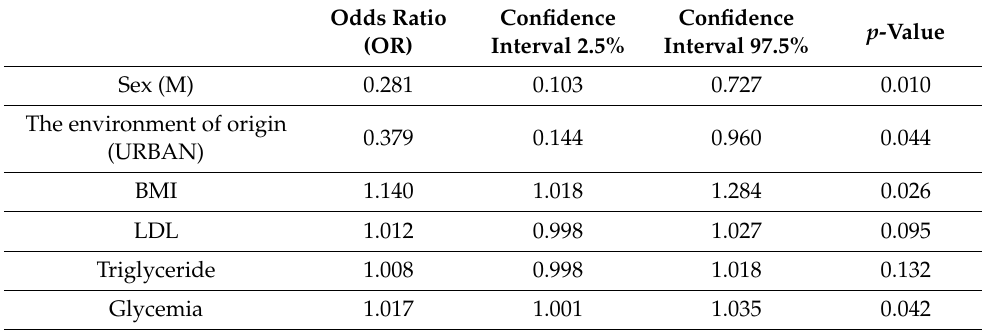
Table 1. An ordinal logistic regression model including all considered covariates. Odds Ratio (OR) Interval